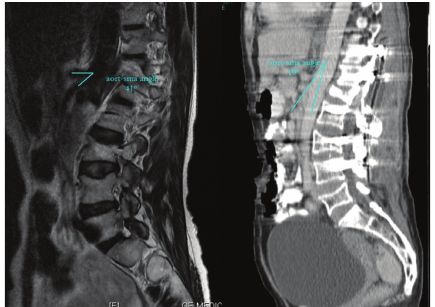
Figure 4: Preoperative and postoperative angle of superior mesen- teric artery in computerized